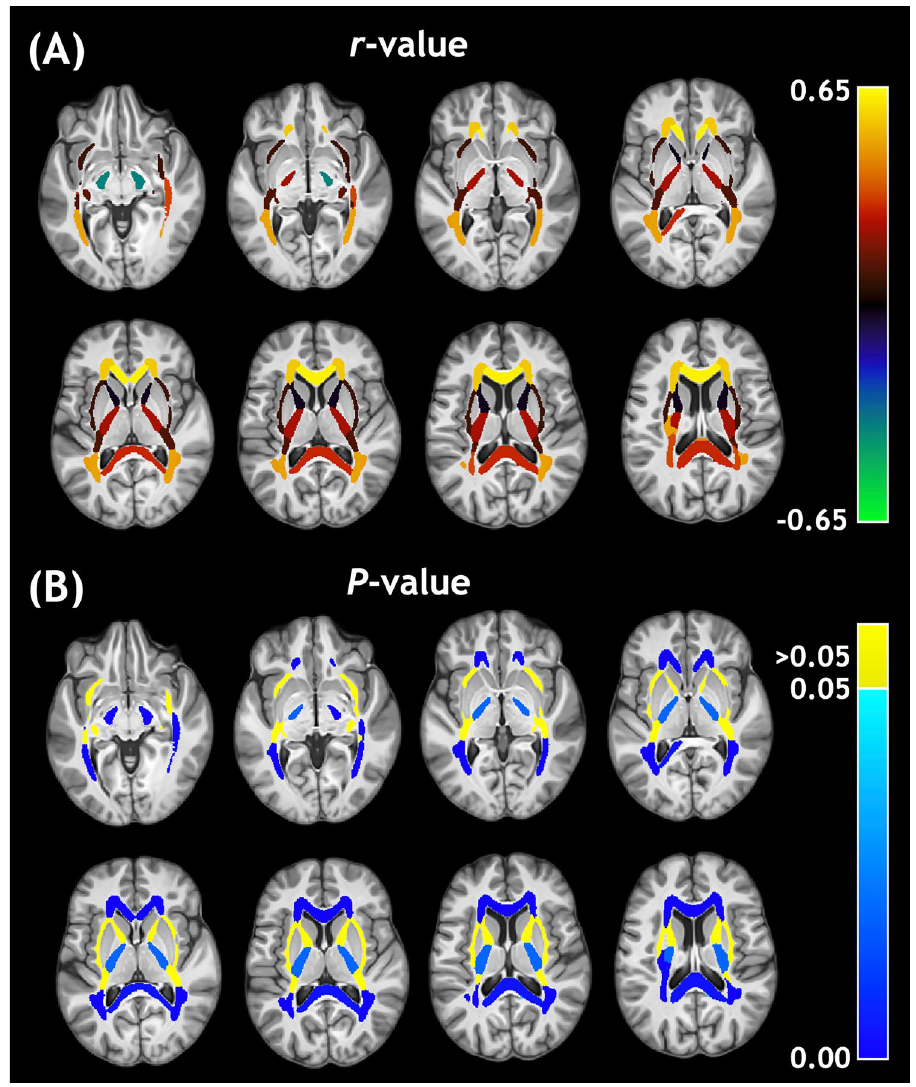
Figure 3. Pearson ( A ) correlation coefficients ( r -values) and ( B ) P -values for the relationship between age and geometric mean T 2 of intra- and extra-cellular